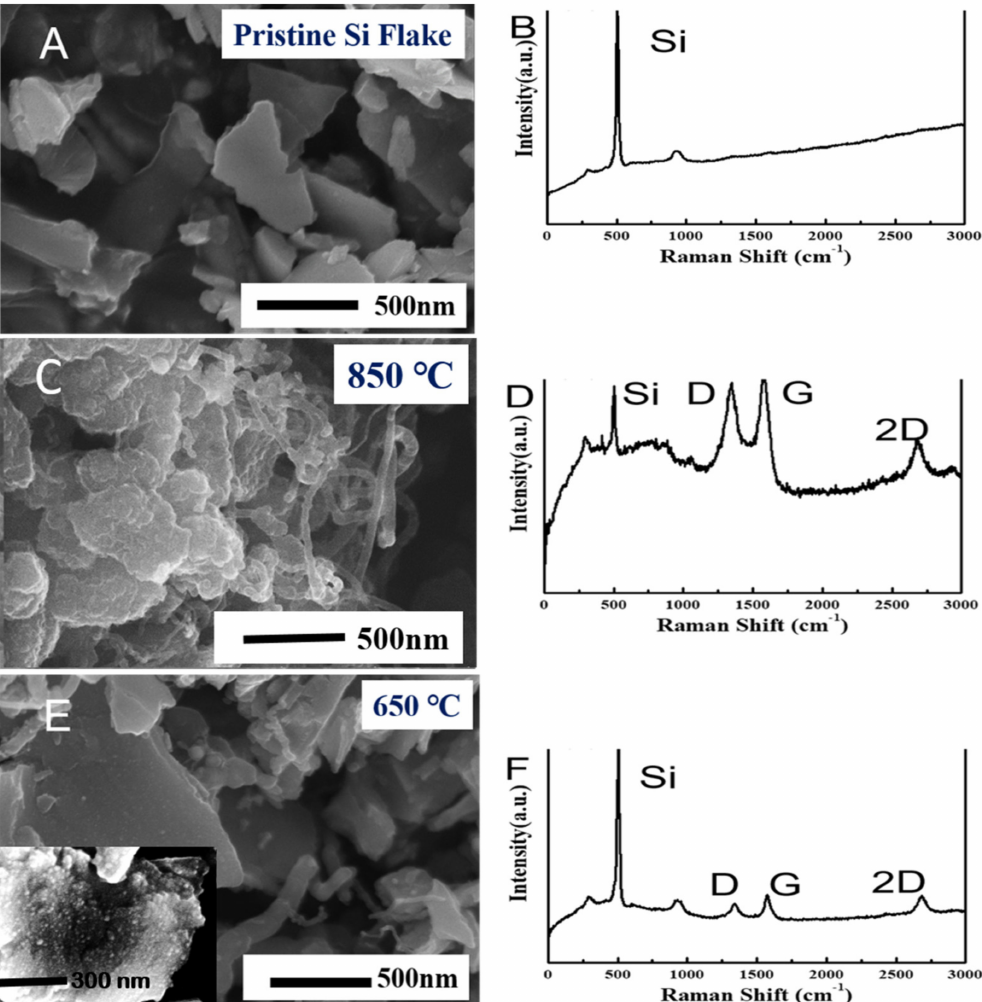
Figure 7. SEM images of silicon flakes ( A ) as received, ( C ) after nanocarbon coating at 850 ◦ C, and ( E ) after nanocarbon coating at 650 ◦ C. Corresponding Raman spectra of silicon flakes ( B ) as received, ( D ) after nanocarbon coating at 850 ◦ C, and ( F ) after nanocarbon coating at 650 ◦ C. The inset in ( E ) is an enlarged image of the surface of a silicon